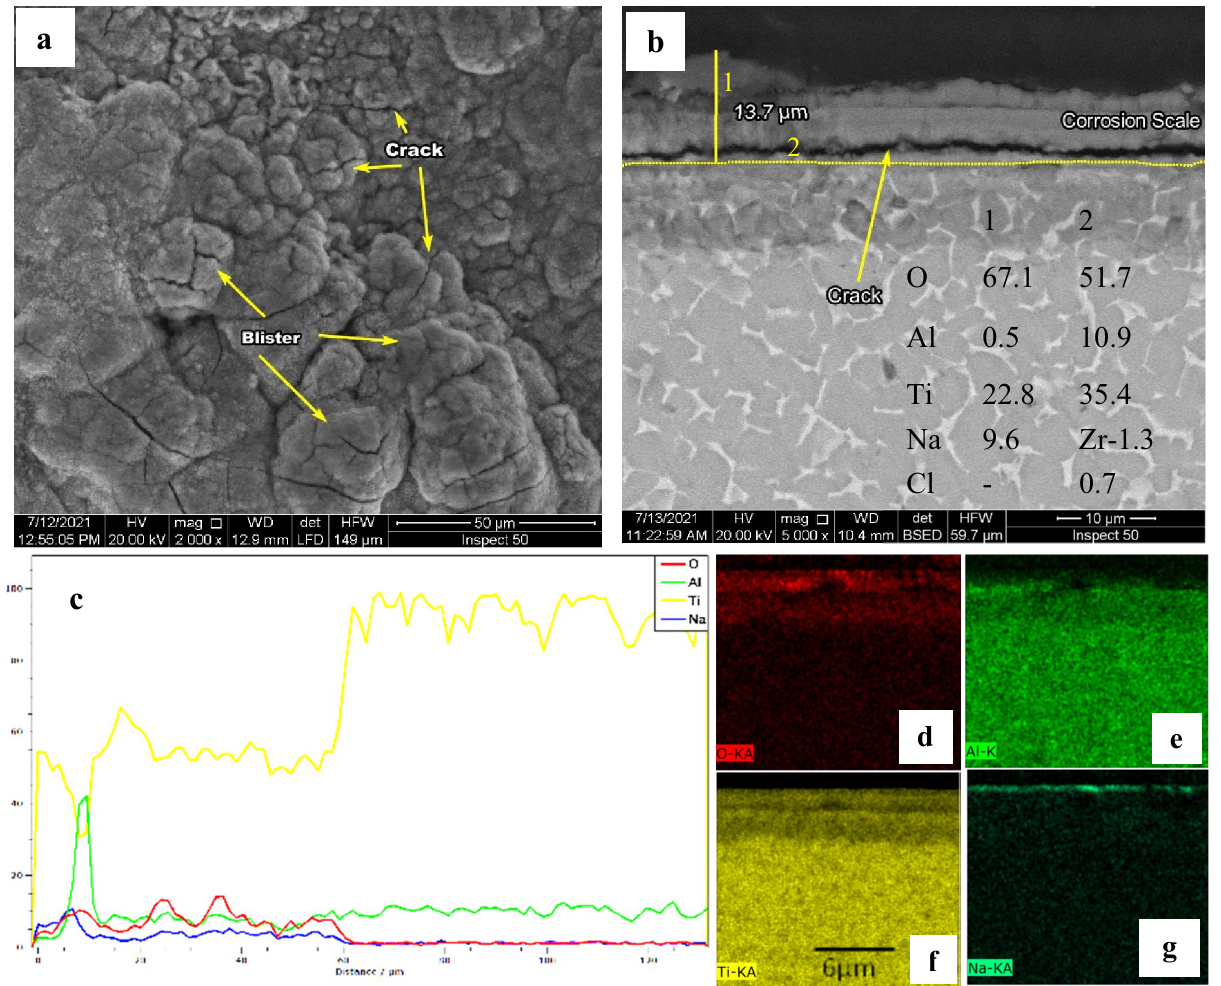
Figure 15. SEM and EDS analysis for oxide 600 °C after hot corrosion ( a ) surface morphology, ( b ) cross- section , ( c ) line element distribution, and ( d–g ) element map